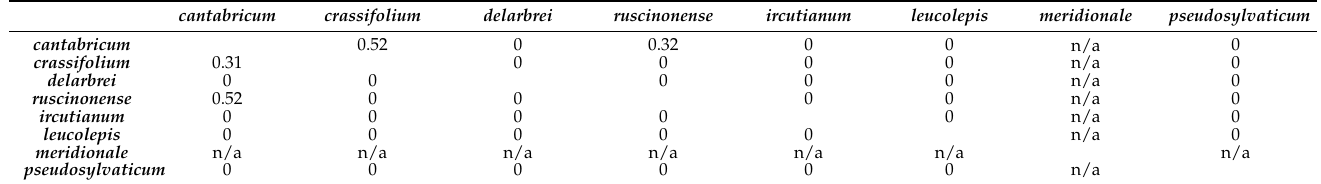
Table 2. Bonferroni-corrected p -values for pairwise niche equivalency tests based on the two test statistics, D (upper triangle) and I (lower triangle).